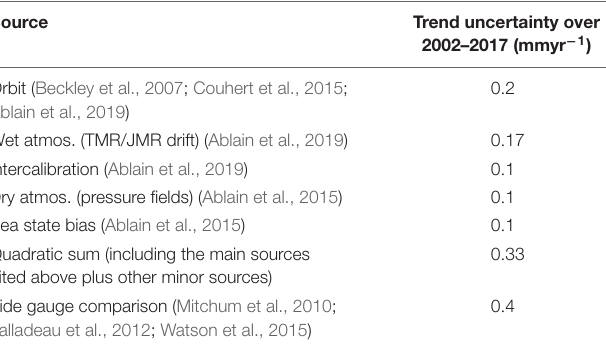
TABLE 2 | GMSL trend uncertainties (in mmyr − 1 ) over 2002–2017 estimated from the error budget approach and from the comparison with tide gauge records. Source Trend uncertainty over 2002–2017 (mmyr − 1